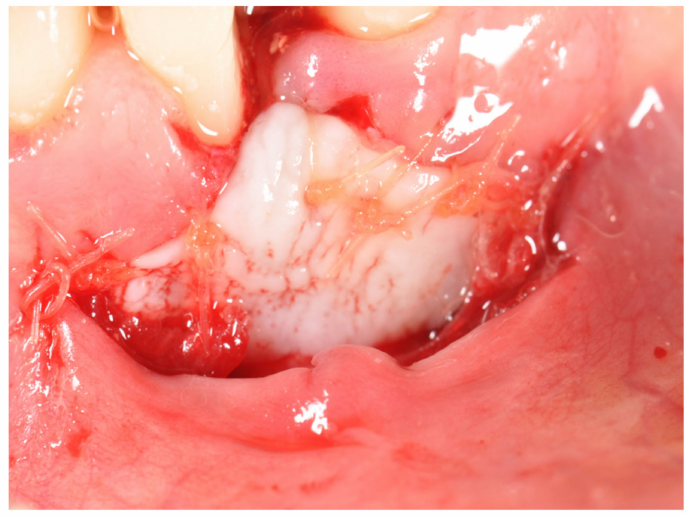
Figure 2. Free gingival graft is adapted and sutured on the recipient site with absorbable